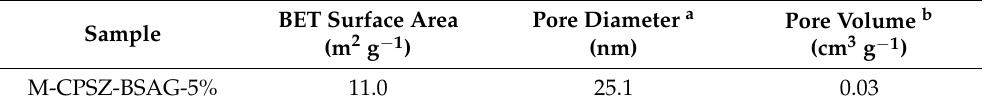
Table 3. Pore structure data (characterized by the BET method) of the ceramic aerogel composite (pyrolyzed at 1000 ◦